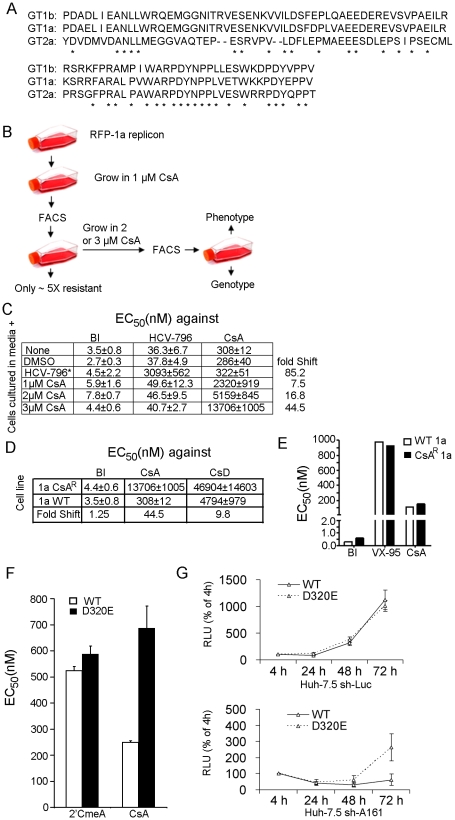
Critical role of NS5A aspartate 316/320 in CsA activity extends to GT 1a.(A) Alignment of NS5A domain II sequences from Con1 (GT 1b), H77 (GT 1a), and JFH-1 (GT 2a). (B) A diagram of selection of CsA-resistant HCV genotype 1a replicon. Genotype 1a replicon cells were selected by serial passaging in the presence of a selectable marker and either the specified antiviral or a comparable volume of solvent. (C) Specific resistance by the selected cells to the selection drug used. The degree to which the EC50 of CsA was shifted corresponded to the concentration of CsA in which the cells were selected. The EC50 of the nonnucleoside NS5B inhibitor HCV-796 is only shifted for the cells selected in HCV-796. (D) Replicon cells selected in 3 µM CsA were cross resistant with a CsA analog that inhibits CyPA but does not bind calcineurin. (E) “Supertransfection” of CsA-resistant replicon cells with a WT 1b replicon showed that resistance to CsA is conferred by mutations in the replicon RNA rather than in the host cell. (F) The D320E mutation, engineered into a WT 1a replicon in isolation, conferred resistance to CsA but not to 2′CMeA. Error bars represent standard derivations of three independent experiments. (G) Transient replication of D320E 1a replicon in sh-A161 cells. A GT1a replicon containing a Renilla luciferase reporter gene was used for this assay. The replication capacities of WT and D320E replicons were measured in both Huh-7.5 sh-Luc and Huh-7.5 sh-A161 cells.